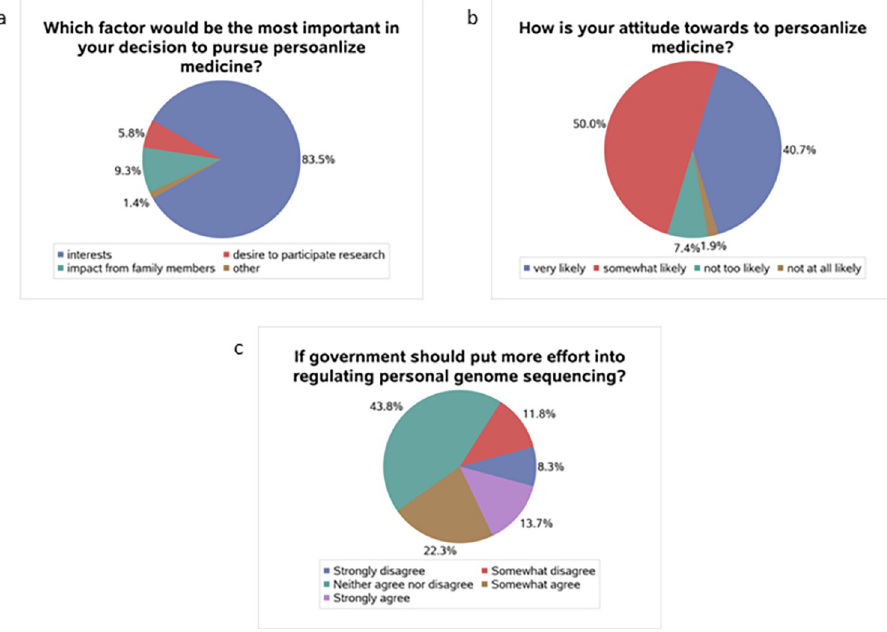
Fig 2. Respondents’ interest and attitude toward personalized medicine. ( a ) which factor would be the most important in participants’ decision to pursue personalized medicine; ( b ) How is participants’ attitude toward personalized medicine; ( c ) if governments should put more effort into regulating personal genome